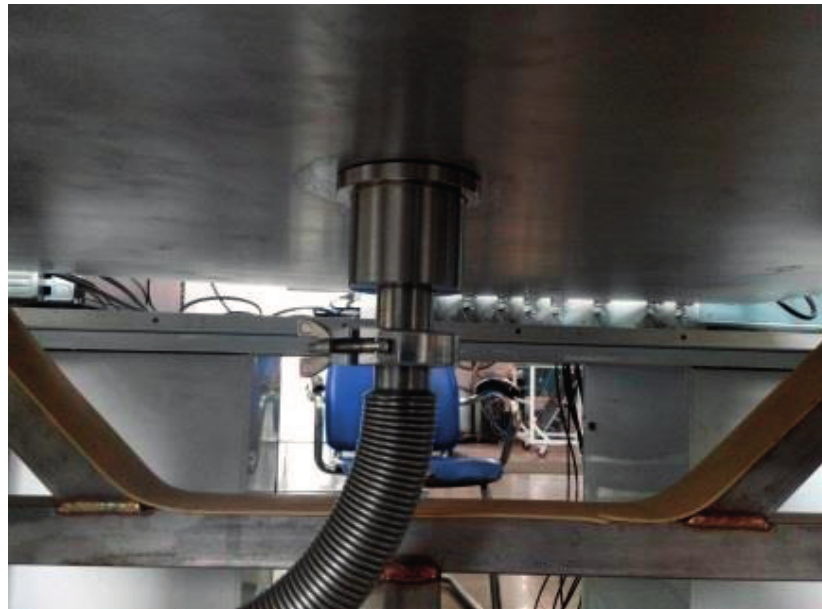
Figure 5. Gas leakage simulation.